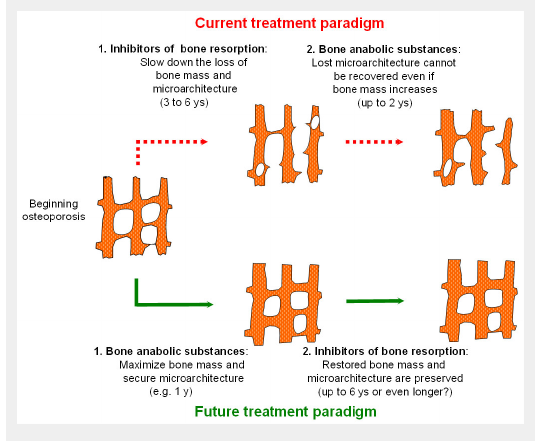
Current and future treatment paradigm of osteoporotic bone loss of bone mass and microarchitecture. According to the current treatment paradigm, antiresorptive drugs are the mainstay first line therapy for reducing fracture risk in patients with osteoporosis and anabolic substances are usually recommended in patients with severe osteoporosis only. As lost bone microarchitecture cannot be recovered, a future treatment paradigm may aim at reversing osteoporosis by maximising bone mass and preserving bone microarchitecture during the early phase of disease progression, the achieved gains being preserved by an inhibitor of bone resorption used in a second